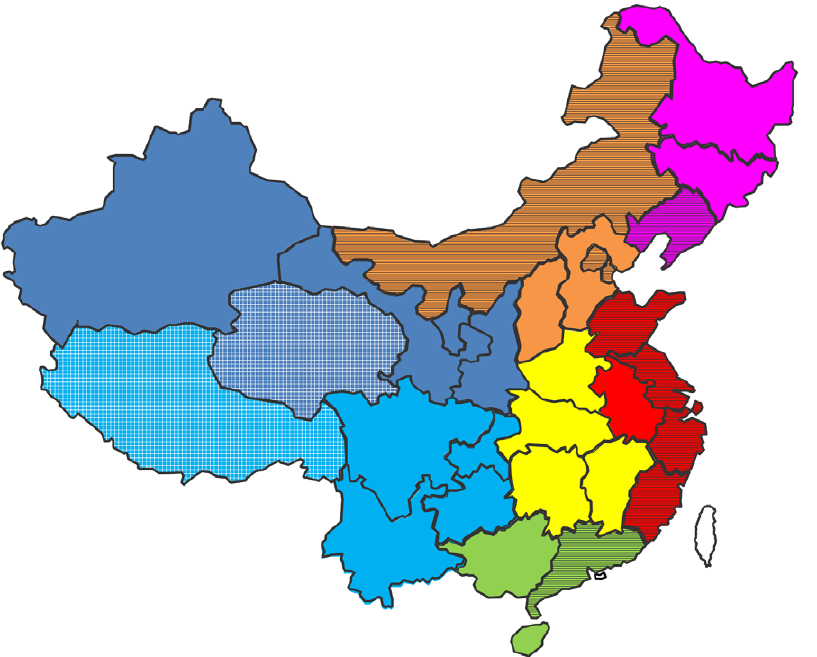
Figure 2. Geographic demarcation of mainland China, color coded as follows: red, East; orange, North; yellow, Middle; green, South; blue, Northwest; cyan, Southwest; violet, Northeast. Two provinces without available data are marked with light grids. The top 10 economic provinces are highlighted by stripes.